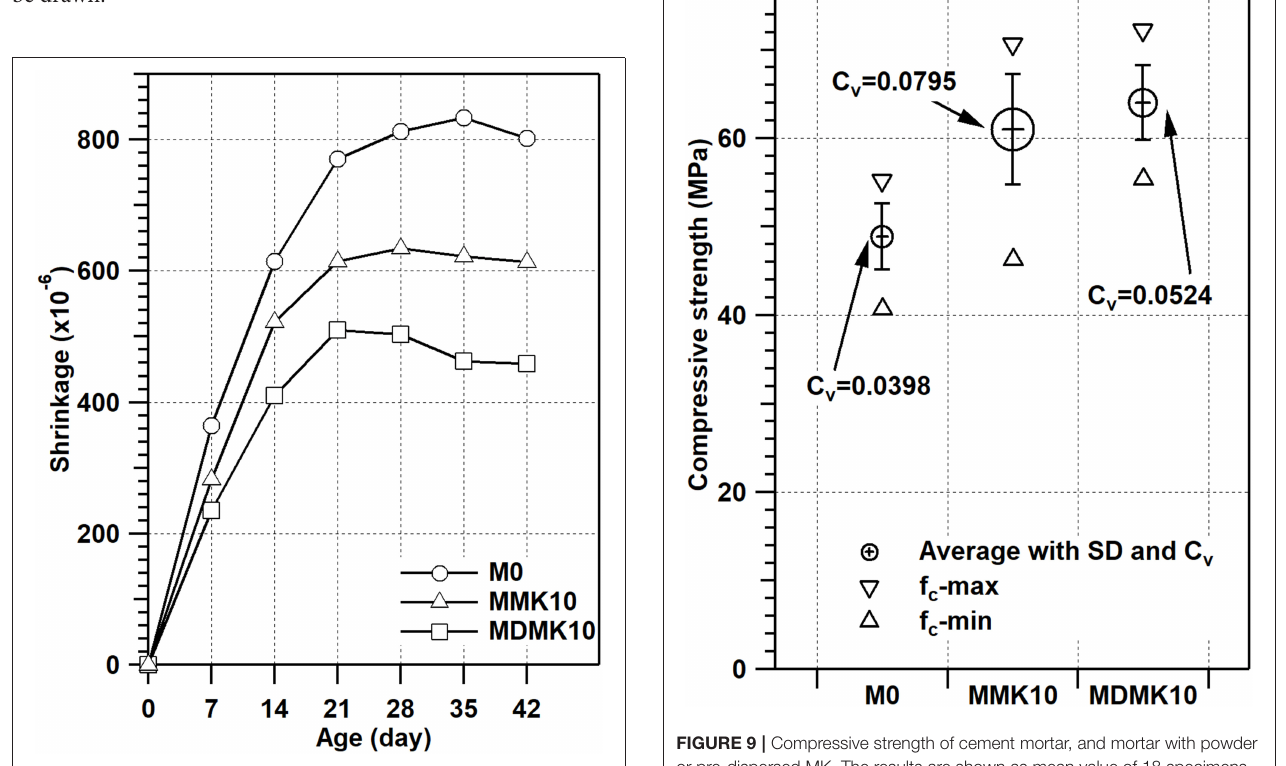
FIGURE 8 | Shrinkage of cement mortar, and mortar with powder or pre-dispersed MK up to 42 days.